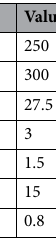
Table 2. DED processing